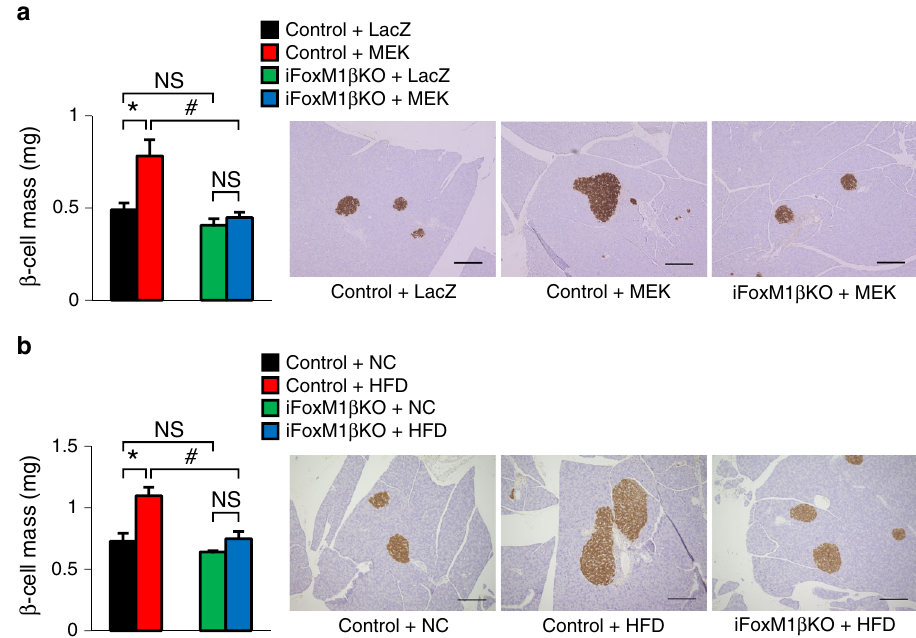
Fig. 3 FoxM1 is essential for vagal signal-induced compensatory β -cell proliferation. a β -Cell mass of iFoxM1 β KO or control mice on day 16 after L-MEK or LacZ administration; representative images are shown in the right three panels. b β -Cell mass of iFoxM1 β KO or control mice fed a high-fat diet (HFD) or normal chow (NC) for 15 weeks; representative images are shown in the right three panels. Scale bar, 200 µ m. Data are presented as means ± s.e.m. NS, not signi fi cant, * P < 0.05, # P < 0.01, assessed by one-way ANOVA. n = 3 –